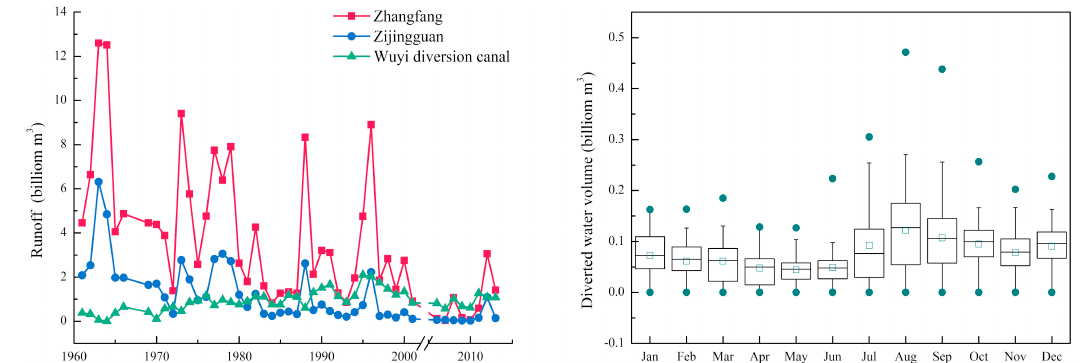
Figure 15. Comparison of annual observed runoff for Zijngguan station, Zhangfang station, and Wuyi diversion canal, and distribution of water withdrawal over the year for Wuyi diversion canal.